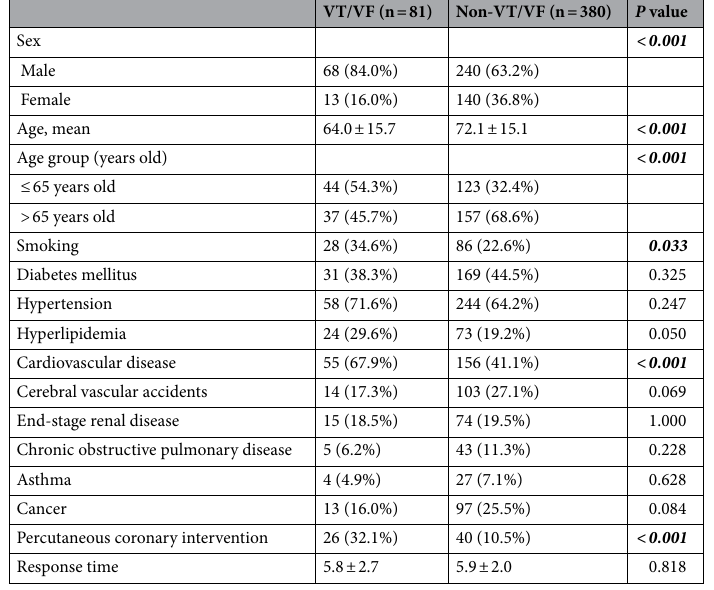
Table 1. Demographic data of witnessed OHCA patients. Statistically significant ( P < 0.05) are given in bold italic. Data are given as the mean ± SD or n (%). Continuous data were analyzed by Student’s t test, and categorical data were analyzed by the chi-square test. OHCA, Out-of-hospital cardiac arrest; VT, ventricular tachycardia; VF, ventricular fibrillation.